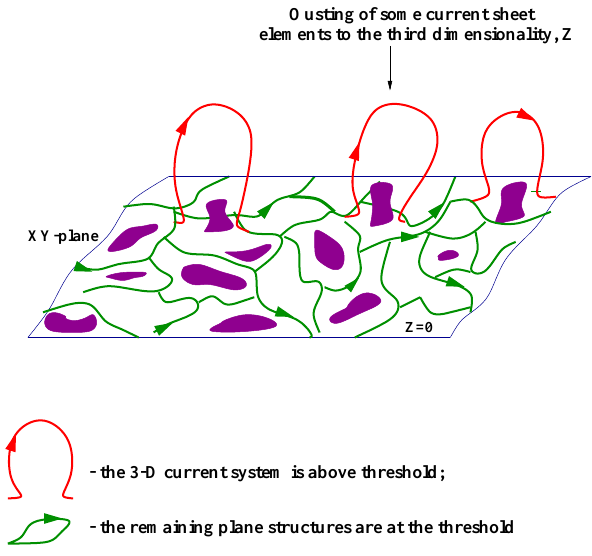
Fig. 15. Scenario of PS filaments